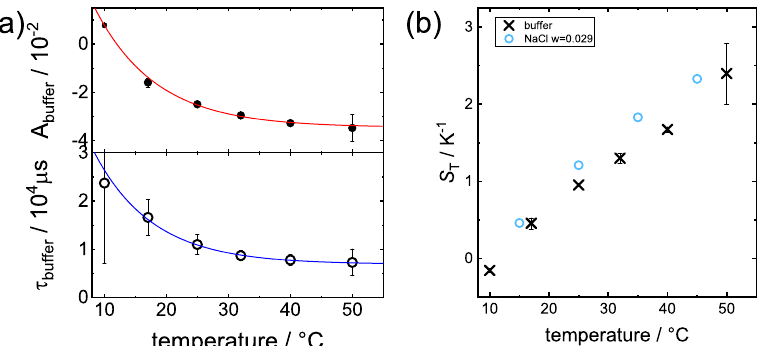
Figure A1. ( a ) Amplitude, A buffer , of the concentration part of the normalized heterodyne signal (cf. Equation (4)) of the buffer solution and ( b ) the corresponding time constant, τ buffer , as function of temperature. The lines correspond to an exponential fit of the data. Note, that the solutions contain 120 mM NaCl corresponding to a weight fraction of w =